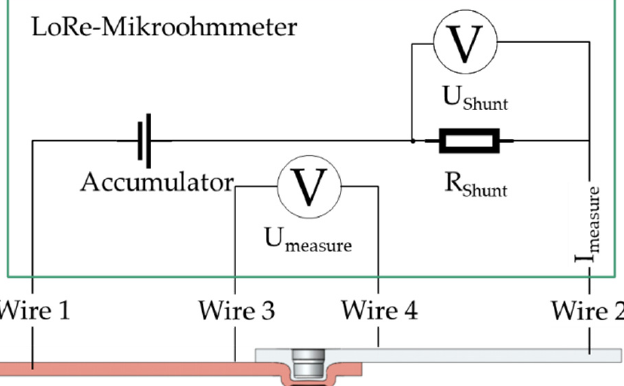
Figure 7. Principle of the resistance measurement of the clinched samples .